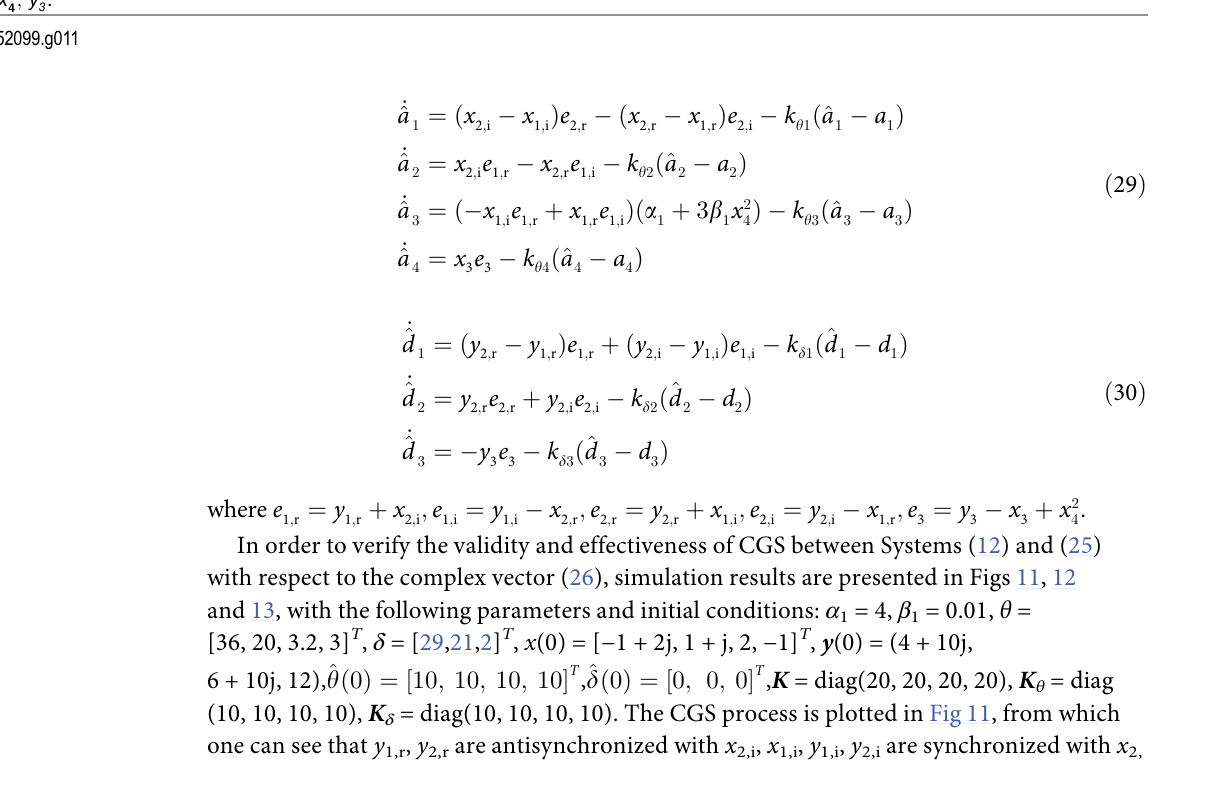
PLOS ONE | DOI:10.1371/journal.pone.0152099 March 24,